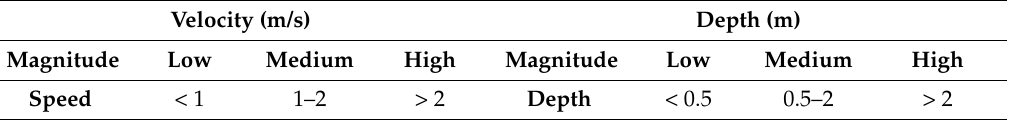
Table 2. Classification criteria proposed by the authors to evaluate the magnitude. Velocity (m/s) Depth